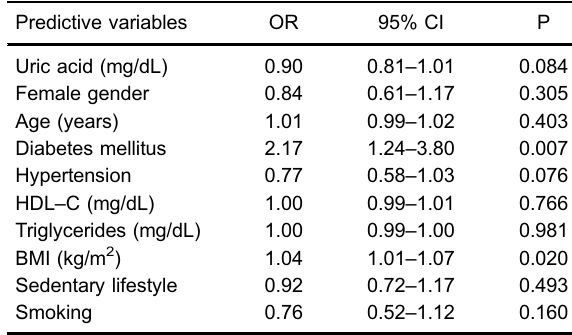
Table 2. Multivariate logistic regression model for predictors of development of glomerular fi ltration rate o 60 mL (cid:1) min – 1 (cid:1) (1.73 m 2 ) – 1 at the end of follow-up.